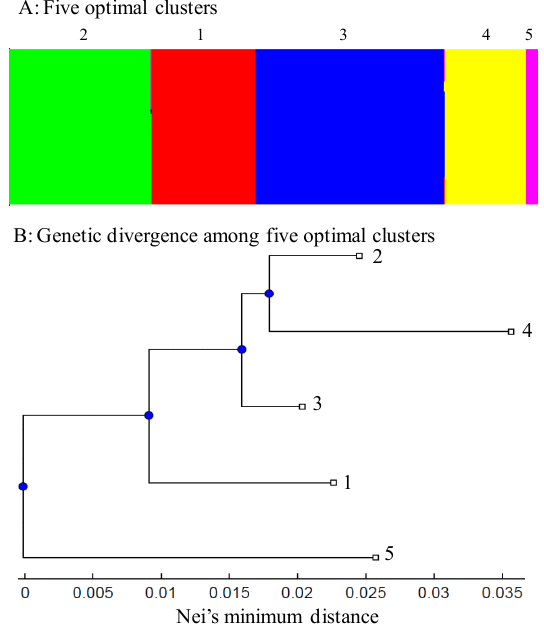
Figure 3. AFLP-based neighbor-joining dendrogram of 625 assayed plants of hairy prairie-clover. The plants of defined patches are labeled with patch number, from the distribution-focus sampling with letter n, and of the North Dakota composite population with s and